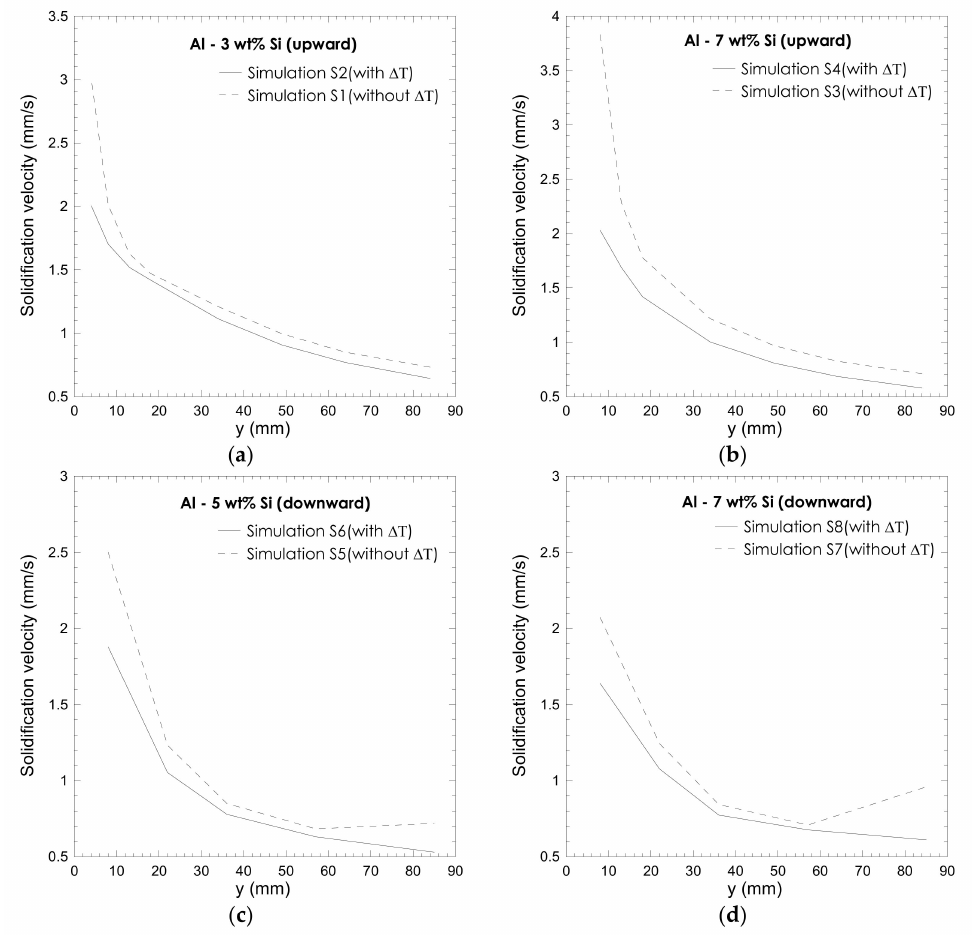
Figure 19. Effect of the undercooling on transient velocity (mm.s − 1 ) of the mushy zone/liquid interface during uni-directional solidification for simulation ( a ) S1 and S2; ( b ) S3 and S4; ( c ) S5 and S6; and ( d ) S7 and